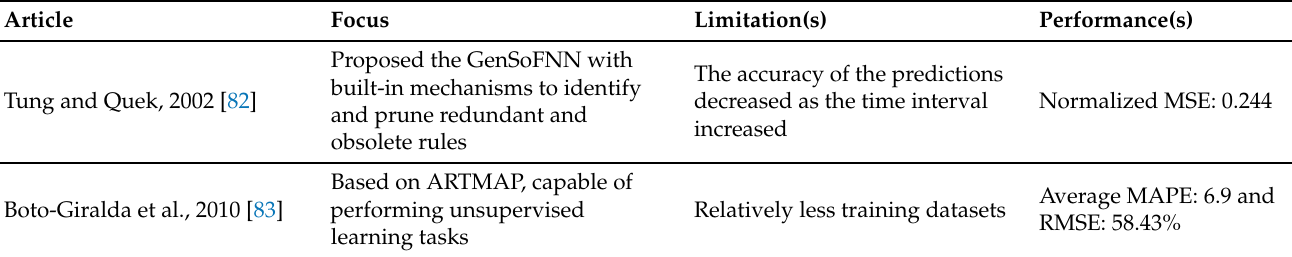
Table 13. Summary of the works found using